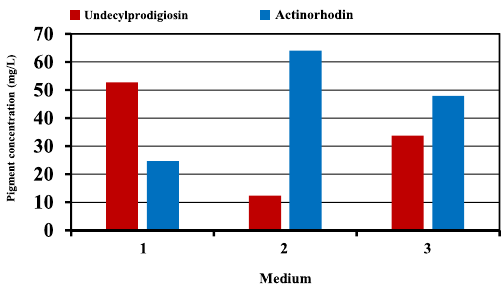
Fig.6. Production of undecylprodigiosin and actinorhodin in cultures supplemented with different carbon sources based on mixture design (medium 1: 3.29 g/L fructose and 6.66 g/L sucrose; medium 2: 10 g/L glucose; medium 3: 7.17 g/L fructose and 2.82 g/L